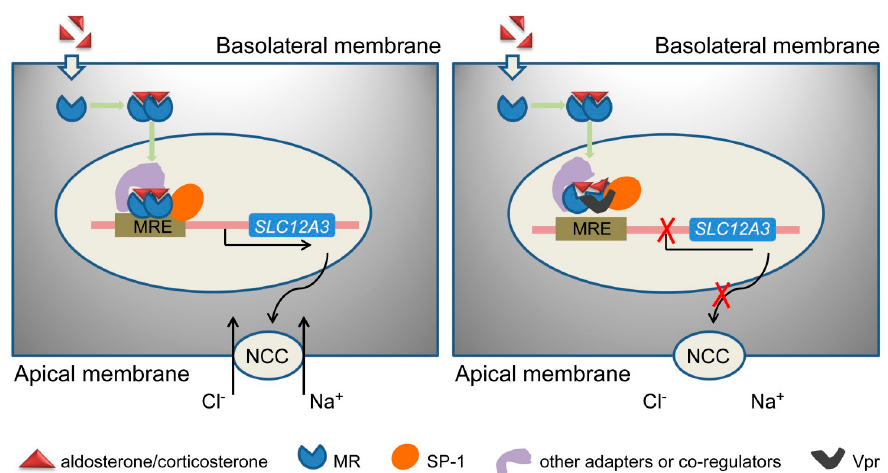
Fig 7. A schematic model of Vpr suppression of SLC12A3 transcription activity in the distal convoluted tubule. ( A ) In the absence of Vpr, aldosterone binds MR in the cytoplasm. The activated MR translocates to the nucleus, where it binds the mineralocorticoid response element (MRE) in genomic DNA. This complex, together with SP1 and other transcription factor(s) and other co-regulator(s), activates the transcription initiation complex and thereby promotes SLC12A3 gene transcription and NCC protein translation. Although both MR (aldosterone) and GR (cortisol, corticosterone etc.) hormones potentially bind to MRE, the presence of 11 β HSD2 in the DCT, especially DCT2, converts cortisol (humans)/corticosterone (rodents) to cortisone, which facilitates MR binding to MRE. ( B ) Vpr, binding either MR or SP1 and other transcription factors, abrogates the interaction of MR and MRE and thus prevents SLC12A3 transcription and translation. This reduces the abundance of NCC in the apical membranes of distal convoluted tubules. Considering that plasma aldosterone levels in Tg mice were similar to those of WT mice, and aldosterone concentrations were increased by salt depletion in both groups, Vpr did not impair aldosterone synthesis and regulation system in Tg mice. Of note, MREs can be located within intron or other regions of the gene, although it is illustrated here in the promoter region of SLC12A3